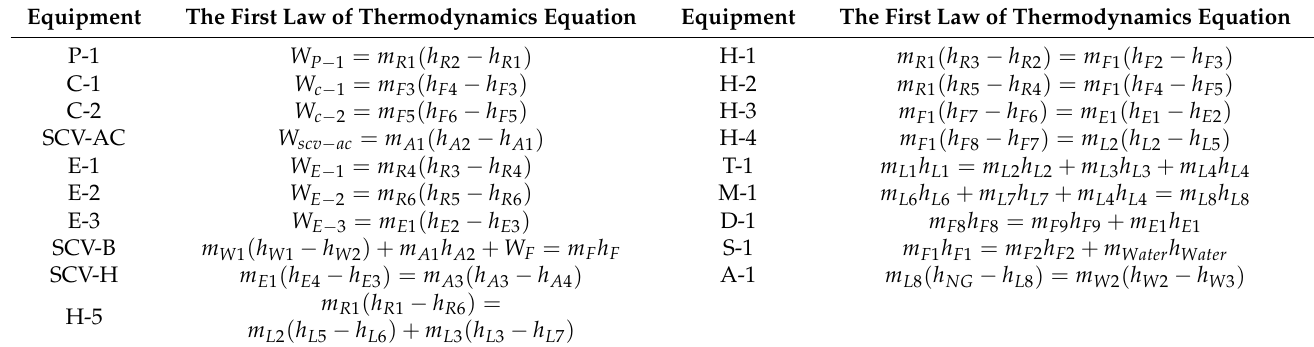
Table 1. The first law of thermodynamics Equation of System A equipment. Equipment Equipment The First Law of Thermodynamics